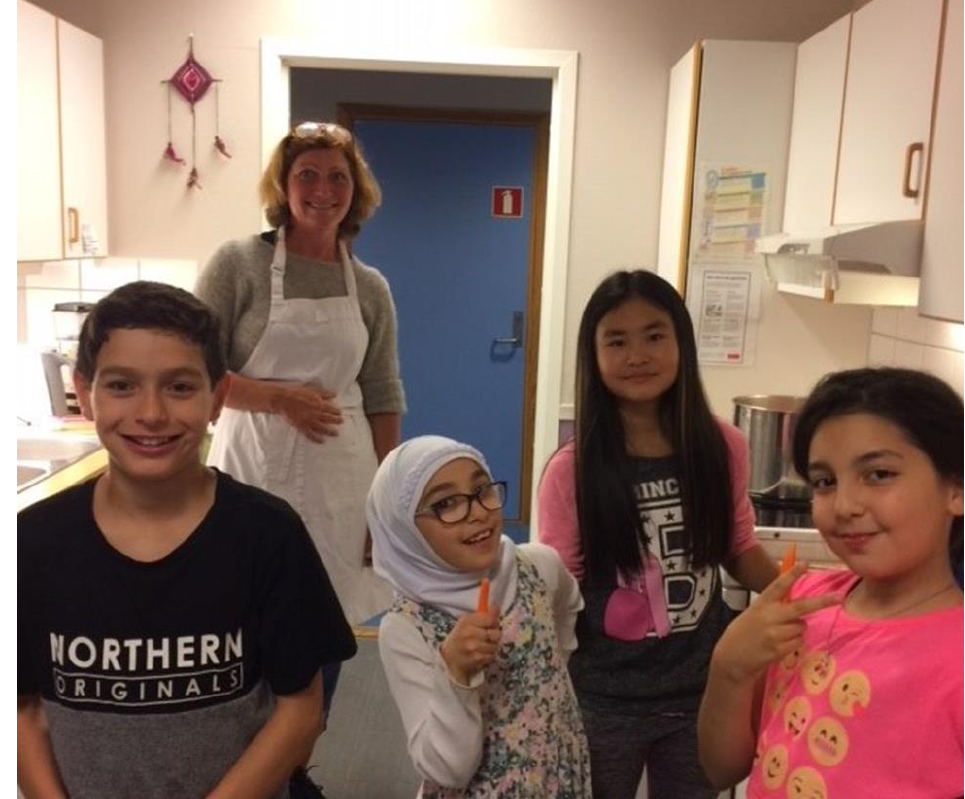
Figure 3. At the school kitchen (photograph taken by School employee 2).